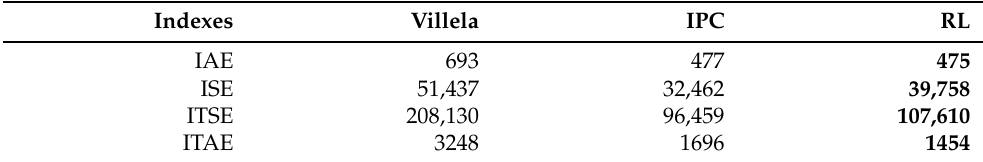
Table 3. Performance indexes X p = − 40 cm, Y p = 0